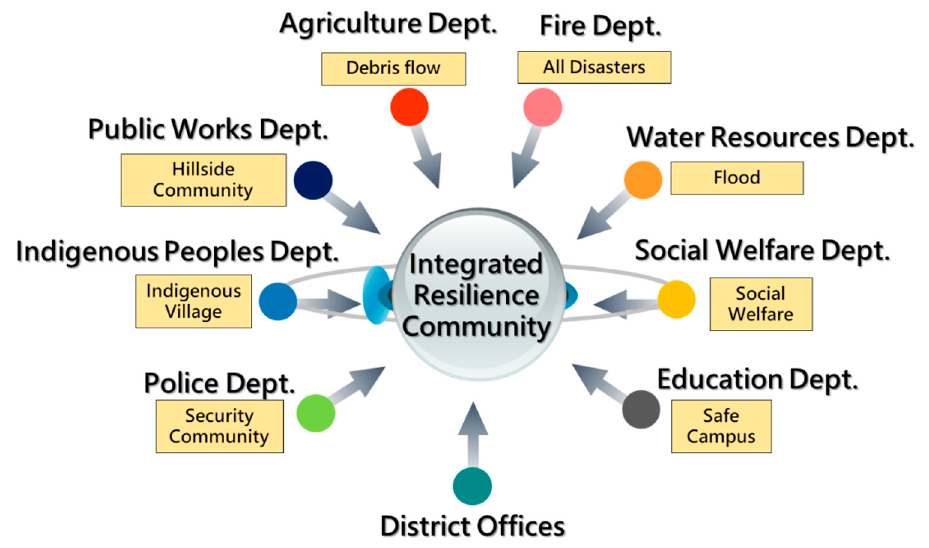
Figure 6. The Concept of Integrated Resilience Community with Associated Authorities Concerned in